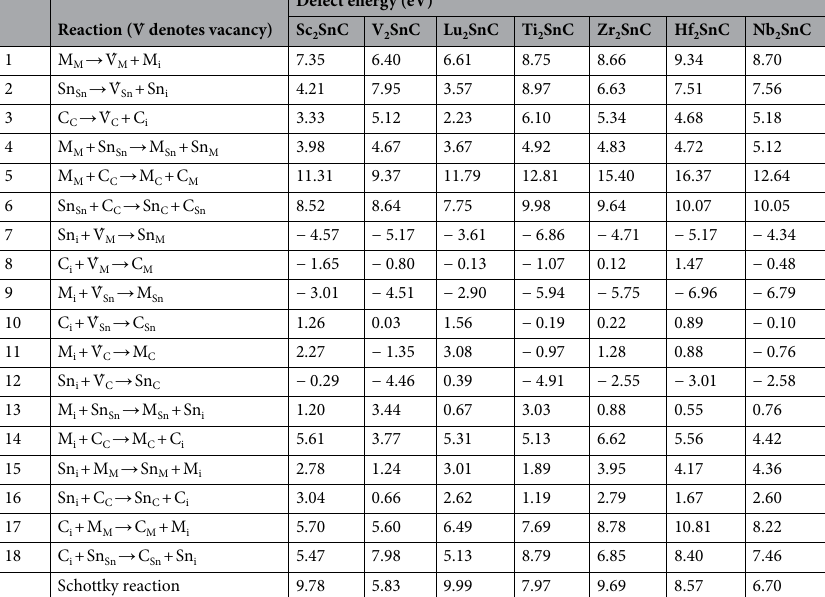
Table 3. The defect reaction energies as calculated for Sc 2 SnC and existing M 2 SnC 4,17 MAX phases.